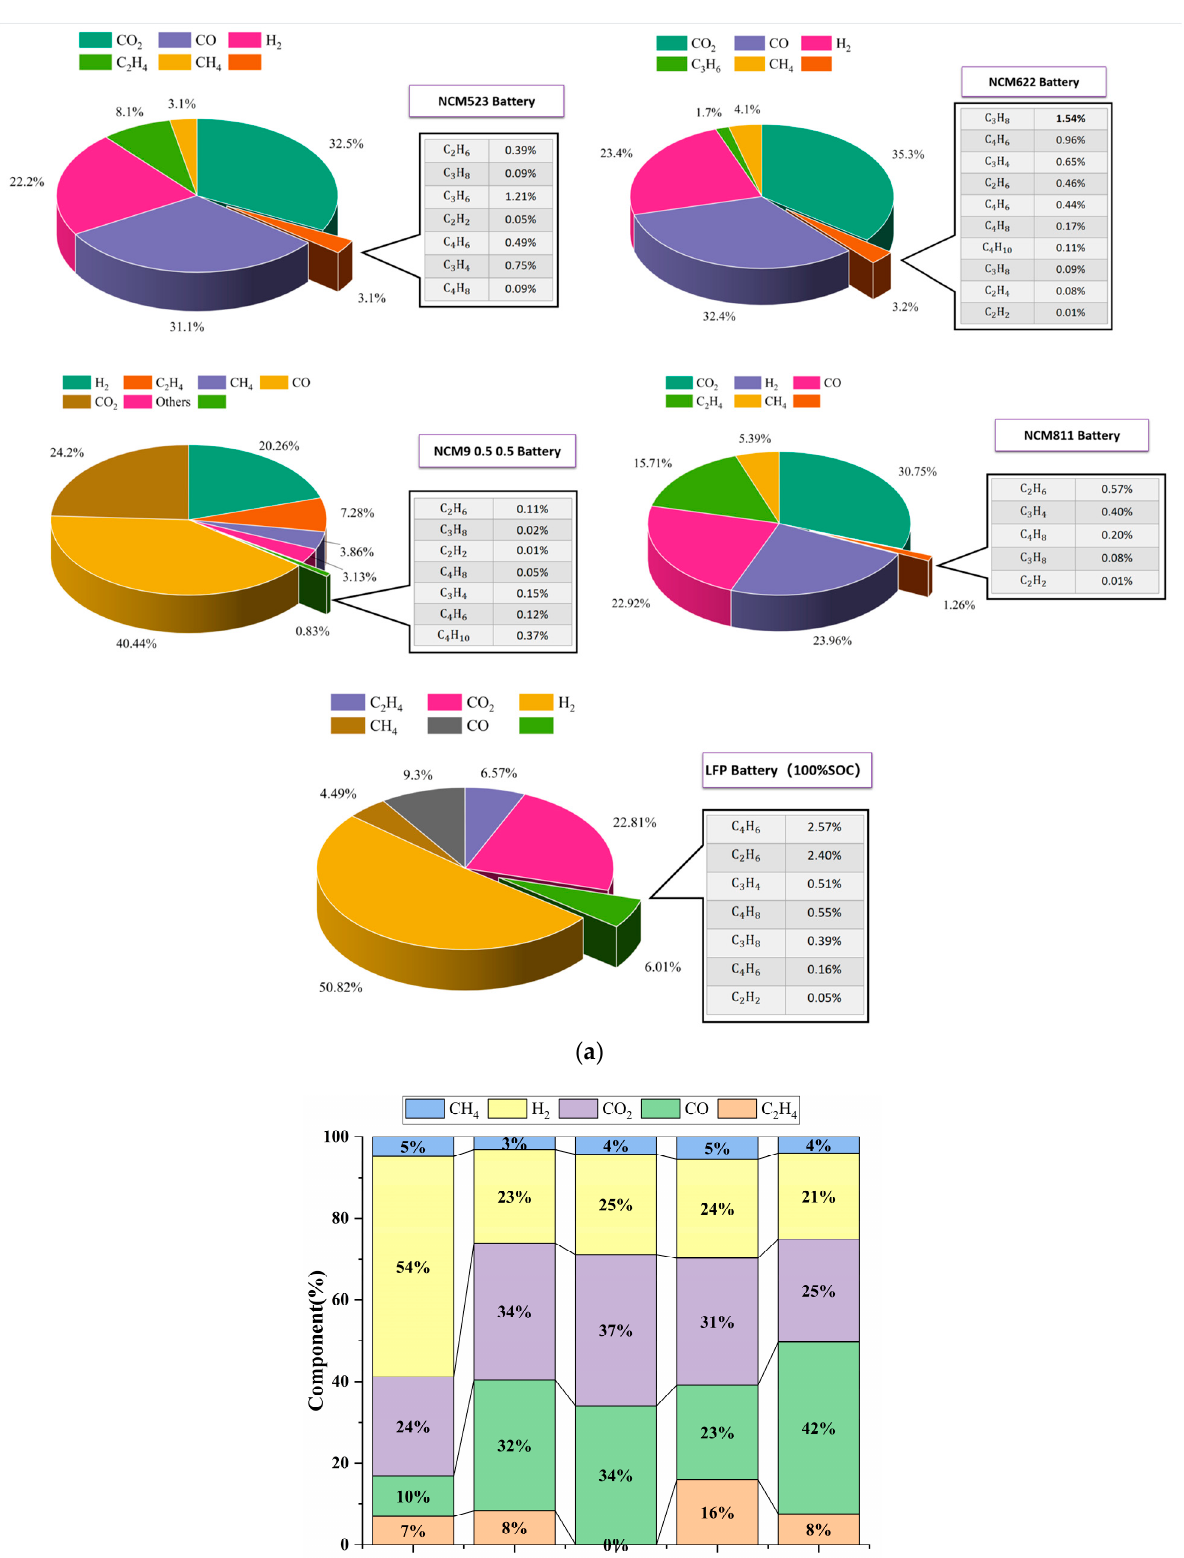
Figure 10. ( a ) Summary of test results of battery gas components. ( b ) Comparison of main gas content in di ff erent ba tt eries after TR.